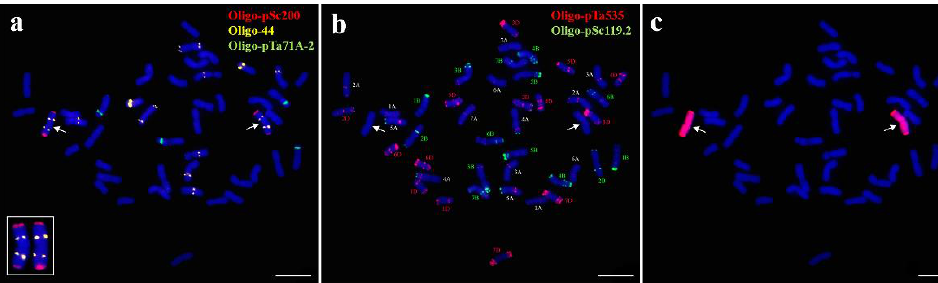
Figure 2. ND-FISH and sequential mc-FISH-GISH analysis of the wheat – P. huashanica disomic addition line 18-1-5. ( a ) ND-FISH analysis of 18-1-5 using Oligo-pSc200 (red), Oligo-44 (yellow), and Oligo-pTa71A-2 (green). ( b ) mc-FISH identification on the same metaphase cell of 18-1-5 using Oligo-pSc119.2 (green) and Oligo-pTa535 (red). ( c ) GISH analysis on the same metaphase cell of 18-1-5 using P. huashanica genomic DNA as a probe (red). Arrows indicate the introduced P. huashanica chromosomes in line 18-1-5. Scale bar: 10 µ m.